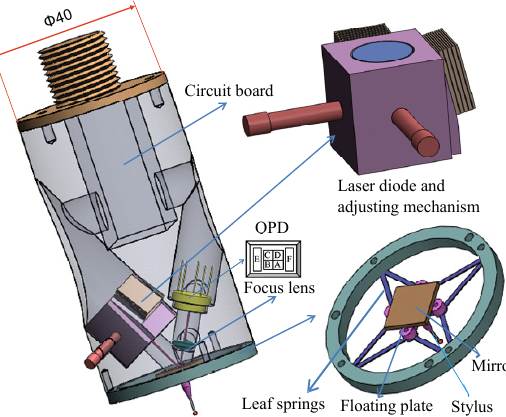
Figure 1. The sketch map of the probe.